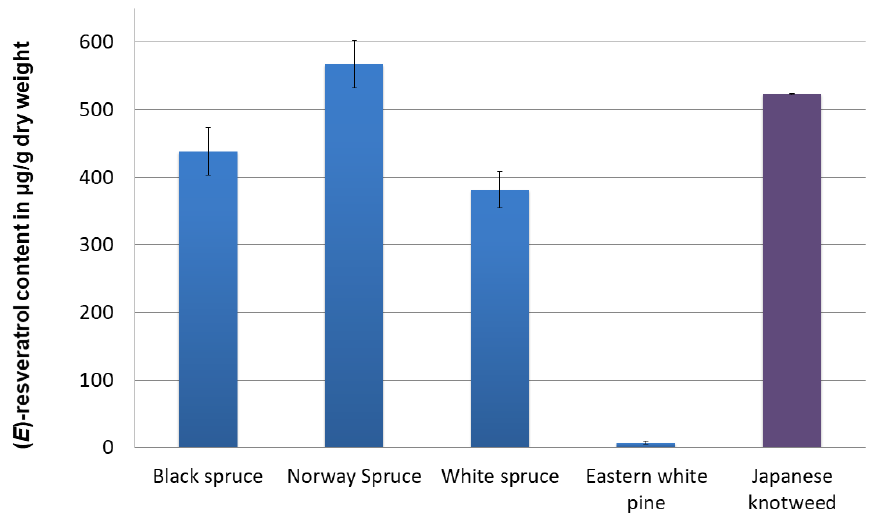
Figure 3. (E)-resveratrol content in ethyl acetate soluble fractions of wood bark extracts determined in this study, and freeze-dried Japanese knotweed ( Polygonum cuspidatum ) root as reported by Burns et al [11].